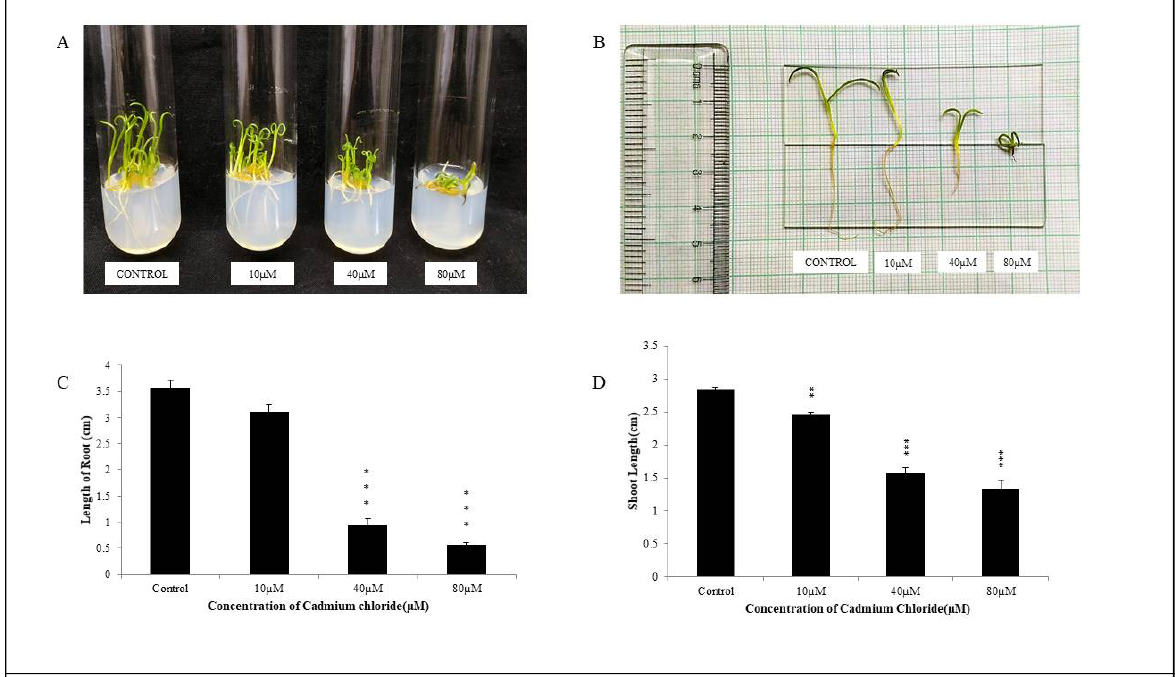
Figure 1: (A) P. ovata plants grown in culture tubes under no stress (control), 10 µ M, 40 µ M, 80 µ M CdCl respectively; (B) Alterations in shoot and root lengths of 7-day old P. ovata plants with increasing levels of CdCl stress; (C) Graphical comparison of root lengths of plants under no stress (control), 10 µ M, 40 µ M, 80 µ M 2 CdCl stress respectively; and (D) Graphical comparison of shoot lengths of plants under no stress(control), 10 2 stress respectively µ M, 40 µ M, 80 µ M CdCl 2 Note: Asterisks denote the level of significance; * p  0.05, ** p  0.01 and *** p 